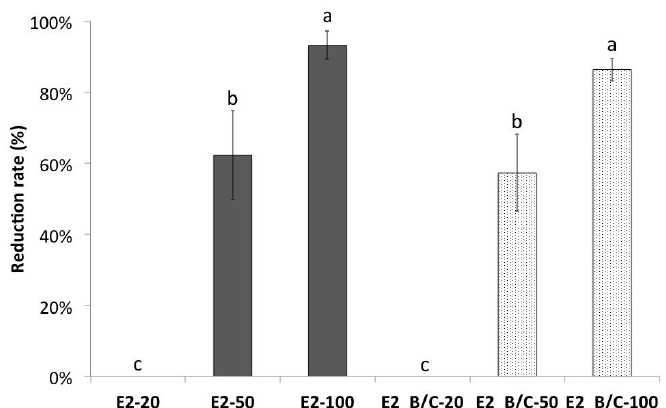
Figure 1. Inhibition of CSFV binding to PK15 cells by recombinant expressed full-length or partial E2 proteins. For this purpose, the full-length E2 protein and domain B/C (E2_B/C) were used. The numbers within the names of the E2 constructs refer to the protein amounts (µg) per 24-well. The data represent the mean and standard deviation of three independent experiments. Values with different superscript letters, a – c, indicate a statistically significant difference ( p < 0.05) from each other. The superscript letter “a” indicates the highest reduction of binding and “c” indicates unchanged binding to cells No significant differences exist between values containing the same letter.